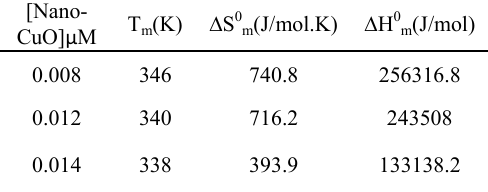
Fig. 1. SEM image of nano-CuO.